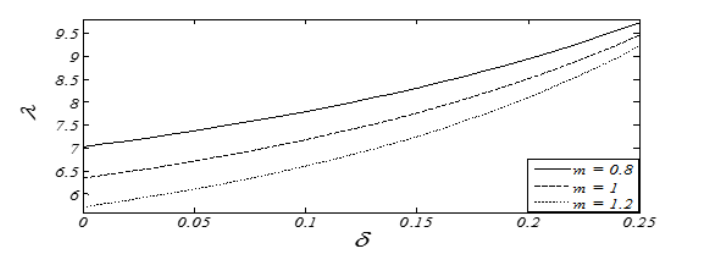
Fig. 12 Resistance impedance for F=0.6, L=1, a=0.2, b=0.4, n=2.